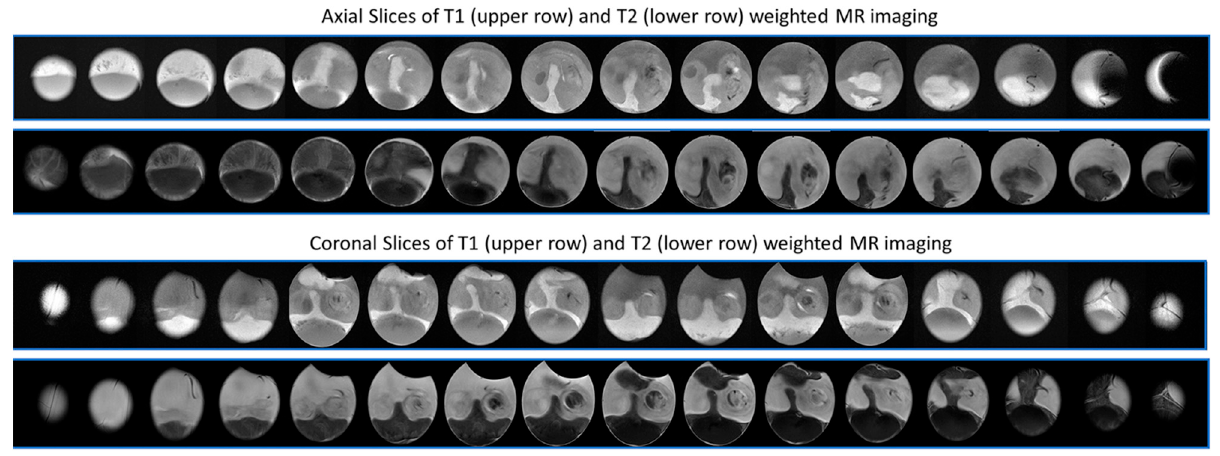
Figure 9. Using a clinical 3.0T Siemens magnetic resonance imaging (MRI) scanner, a chick embryo on ED 12 can be imaged entirely at both axial and coronal slices of 3 mm thickness with both T1 and T2 weighted sequences, reflecting different physiochemical properties of the tissue compo- nents.